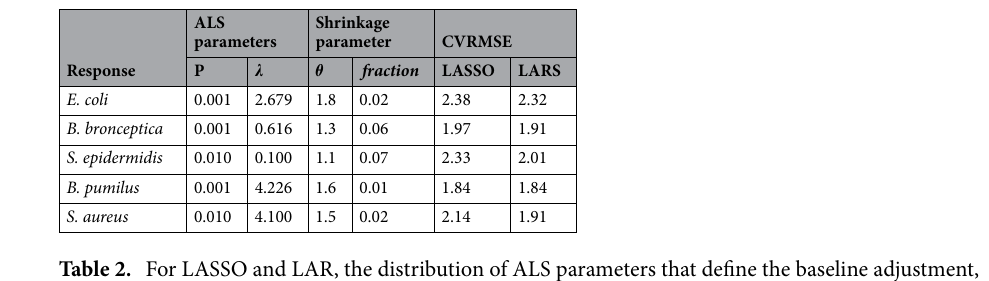
Table 2. For LASSO and LAR, the distribution of ALS parameters that define the baseline adjustment, shrinkage parameters that define the wave-number selection, and RMSE is shown.